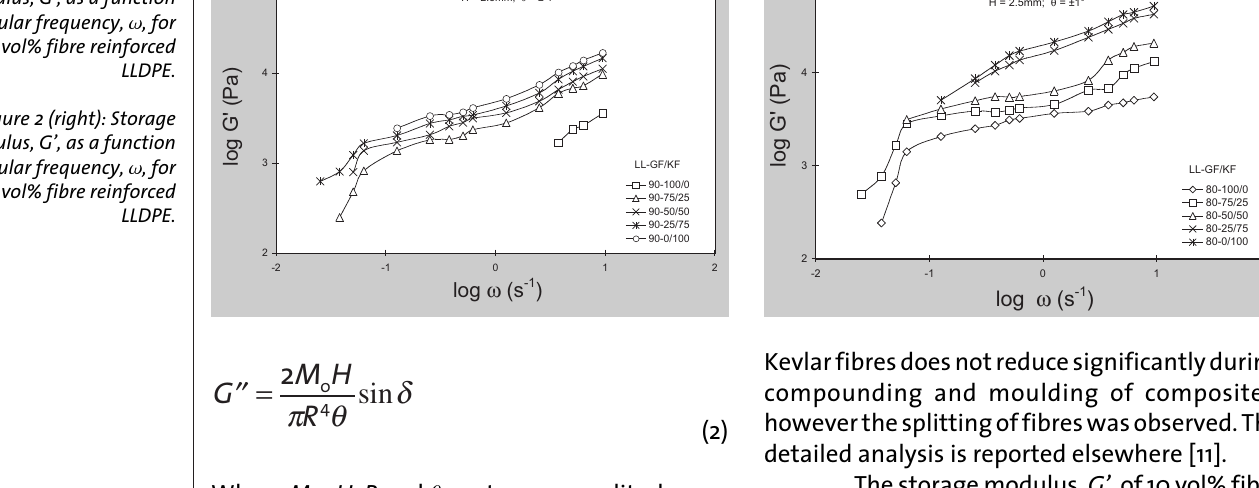
Figure 1 (left): Storage modulus, G’, as a function of angular frequency, w , for 10 vol% fibre reinforced LLDPE. Figure 2 (right): Storage modulus, G’, as a function of angular frequency, w , for 20 vol% fibre reinforced LLDPE.